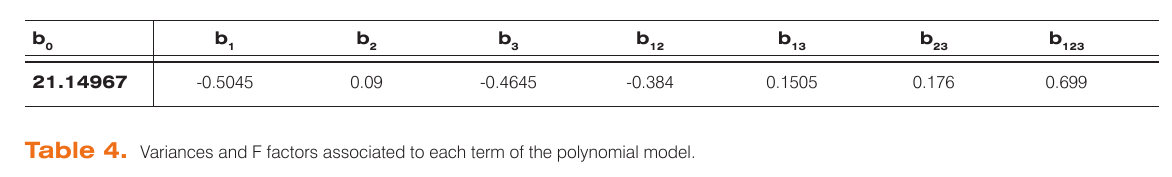
Table 3. Coefficients of the polynomial model.